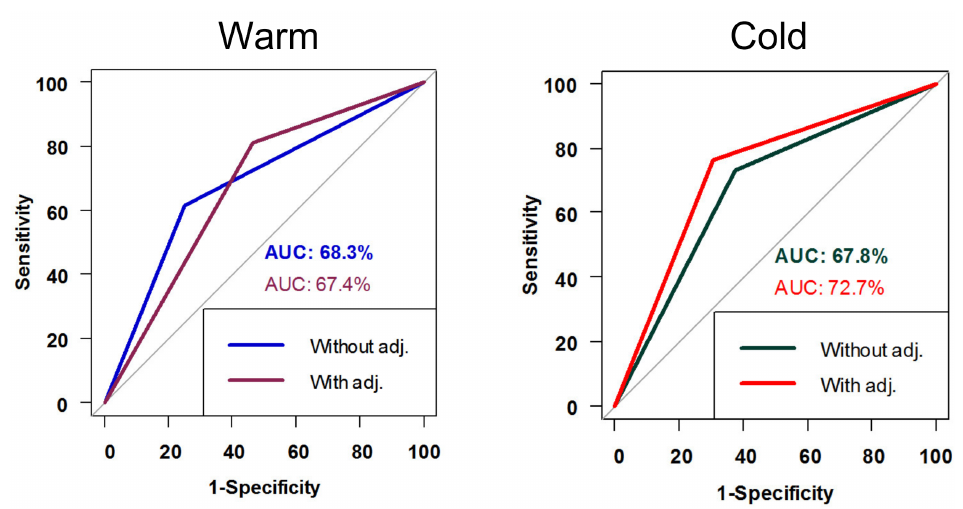
Figure 3. ROC curve for MCA-2 with and without HSN adjustment for both warm and cold